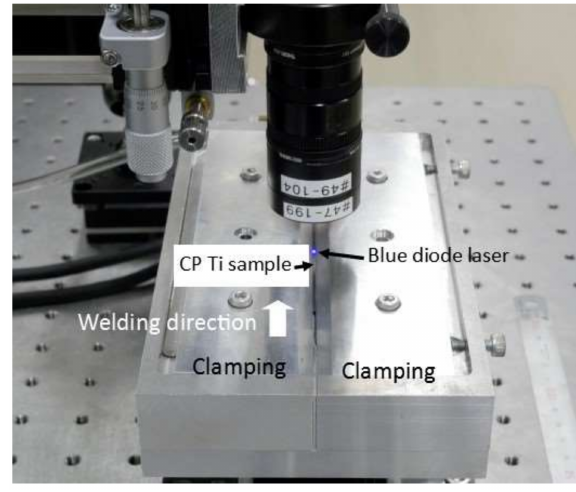
Figure 1. Blue diode laser (BDL) welding set up.